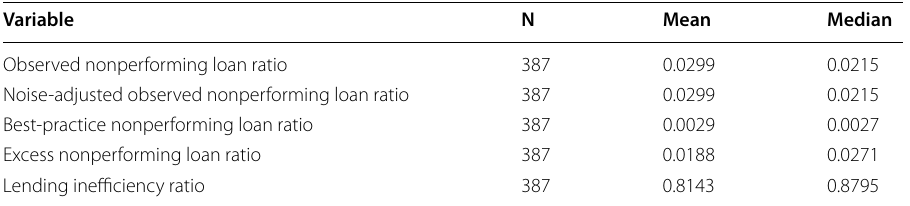
Table 6 2016 unsecured consumer loans. Excluding the volume of unsecured consumer lending. Summary statistics of nonperformance derived from stochastic frontier estimation